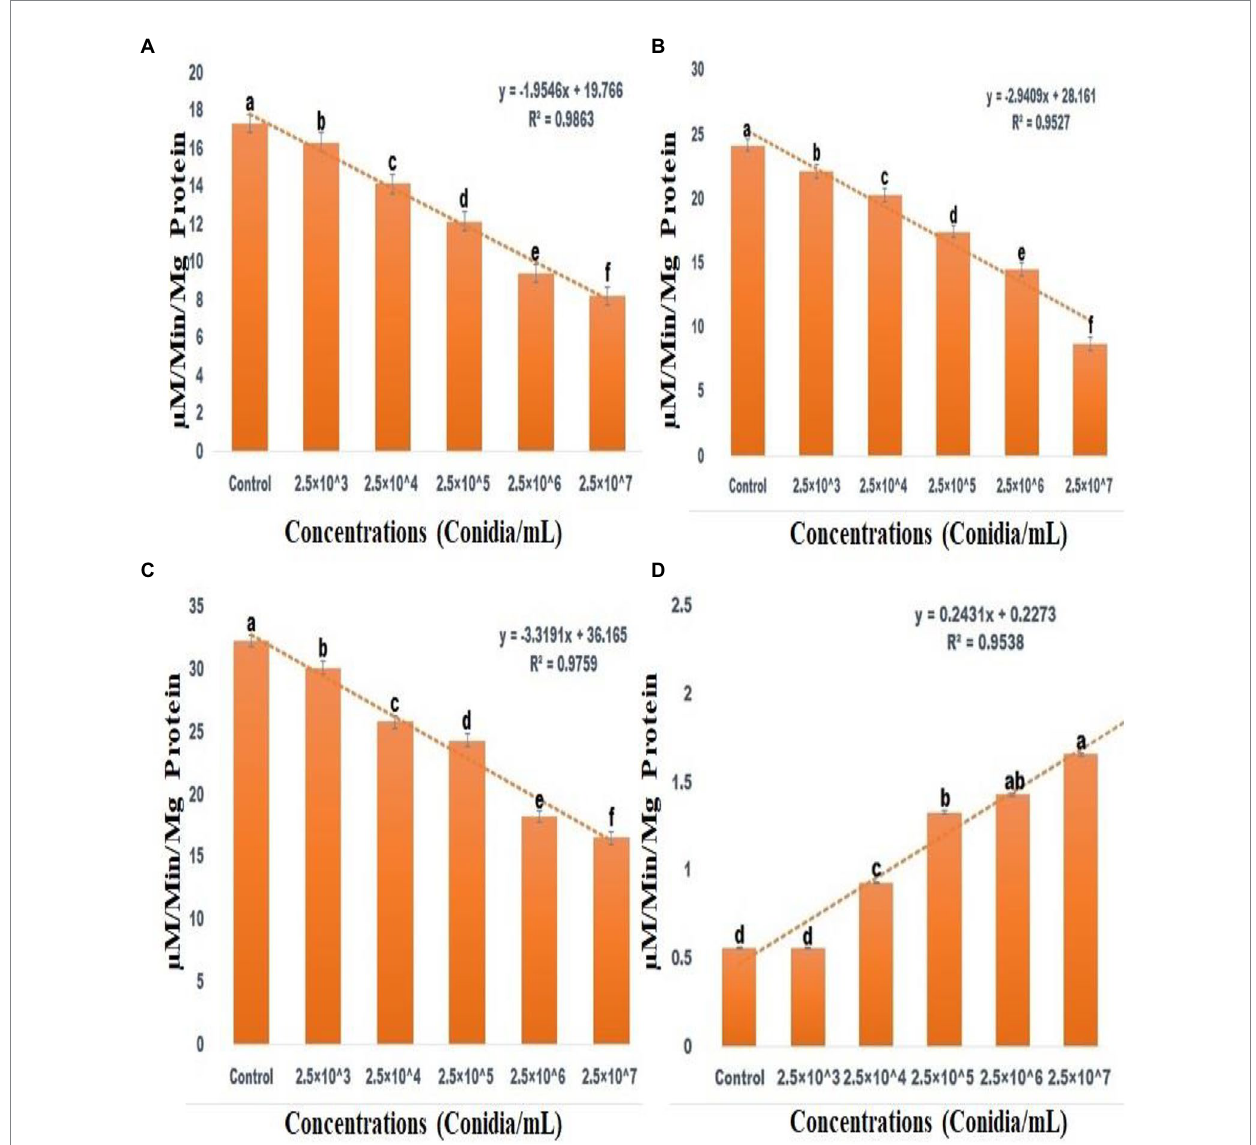
FIGURE 7 Acid Phosphatase activity (A) , Alkaline Phosphatase activity (B) , CAT assay (C) , Superoxide dismutase activities (D) . According to the Tukey test at p = 0.05, statistical values followed by the same letter do not differ significantly (one-way